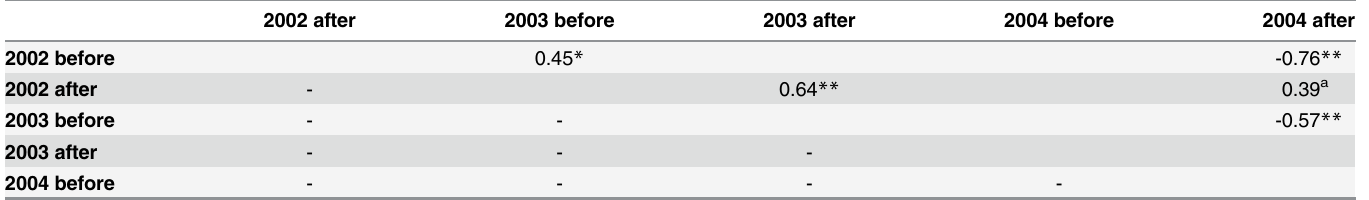
Table 4. Values of Spearman correlations (Rho) between the top 24 diet items (Table 3) of the ptarmigan diet before and after